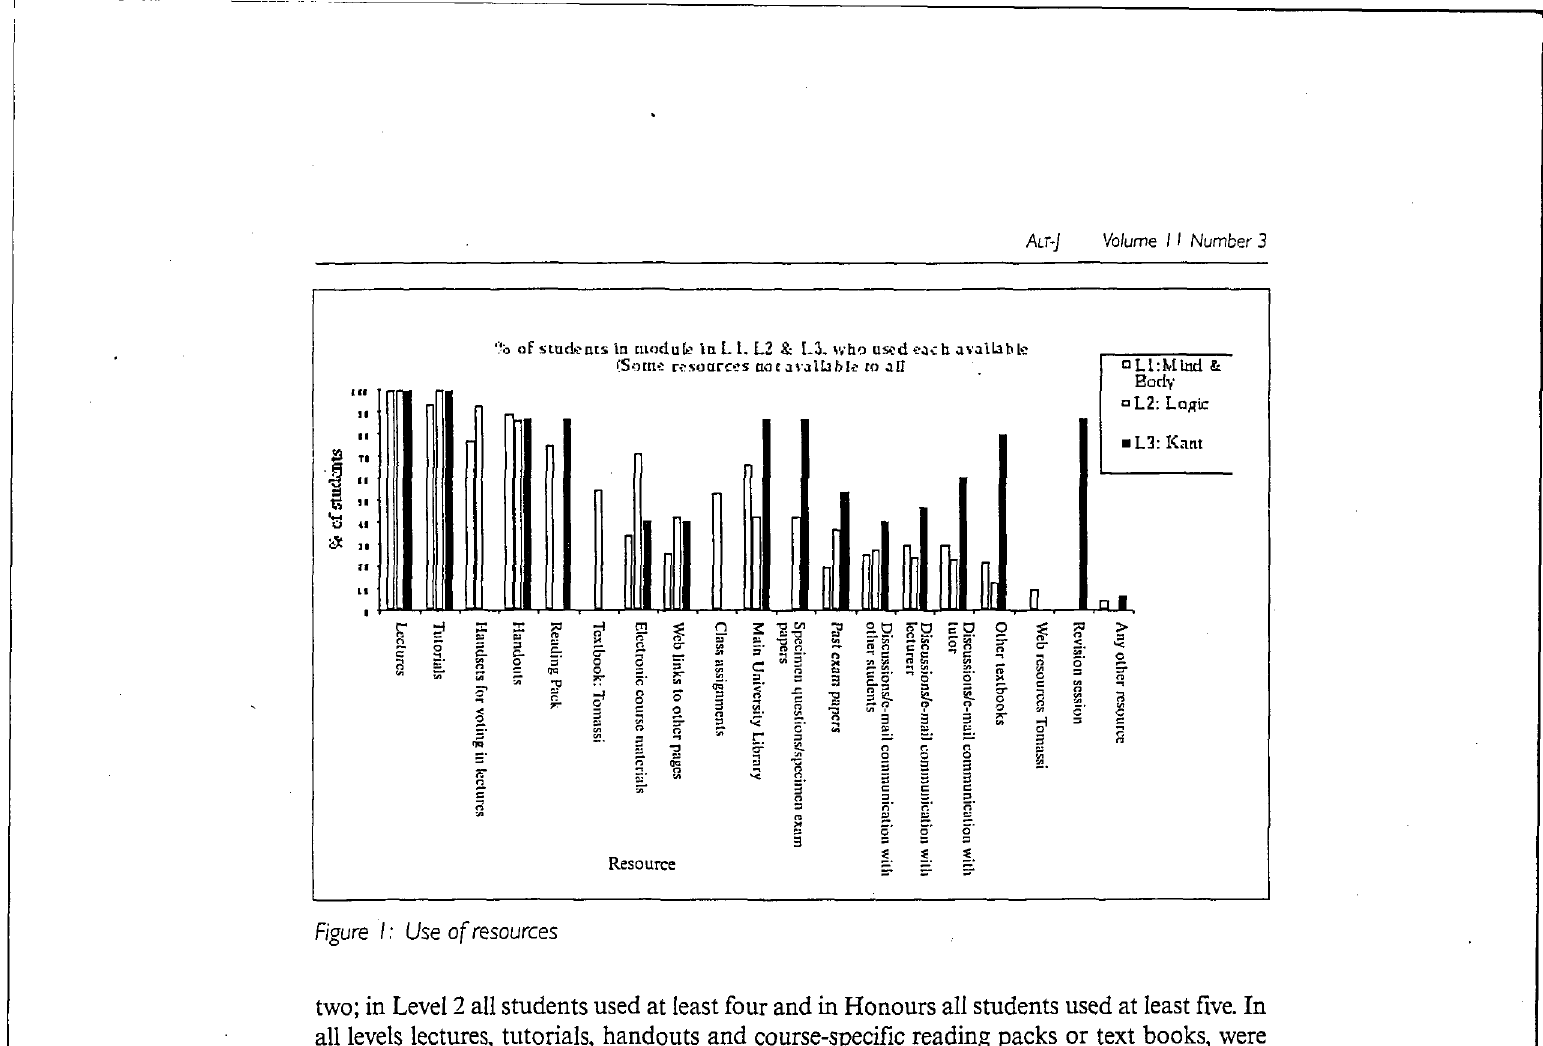
figure /: Use of resources two; in Level 2 all students used at least four and in Honours all students used at least five. In all levels lectures, tutorials, handouts and course-specific reading packs or text books, were used by more than 50 per cent of the class. In Level 1 and Honours, though not in Level 2, the library was also used by more than 50 per cent of the class. The light use of the library by Level 2 students may have resulted from the seemingly self-contained nature of the Logic course. There was a set text - Paul Tomassi's Logic (1999) - that all students taking the logic component were advised to buy; electronic course materials and class assignments were made available to the students in the lectures and on the Web. From this they may have concluded - not unreasonably - that it was not a course that required supplementary